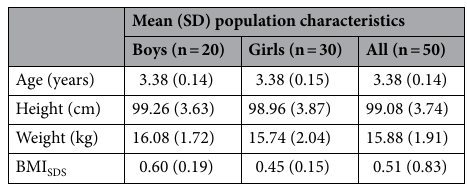
Table 1. Study population